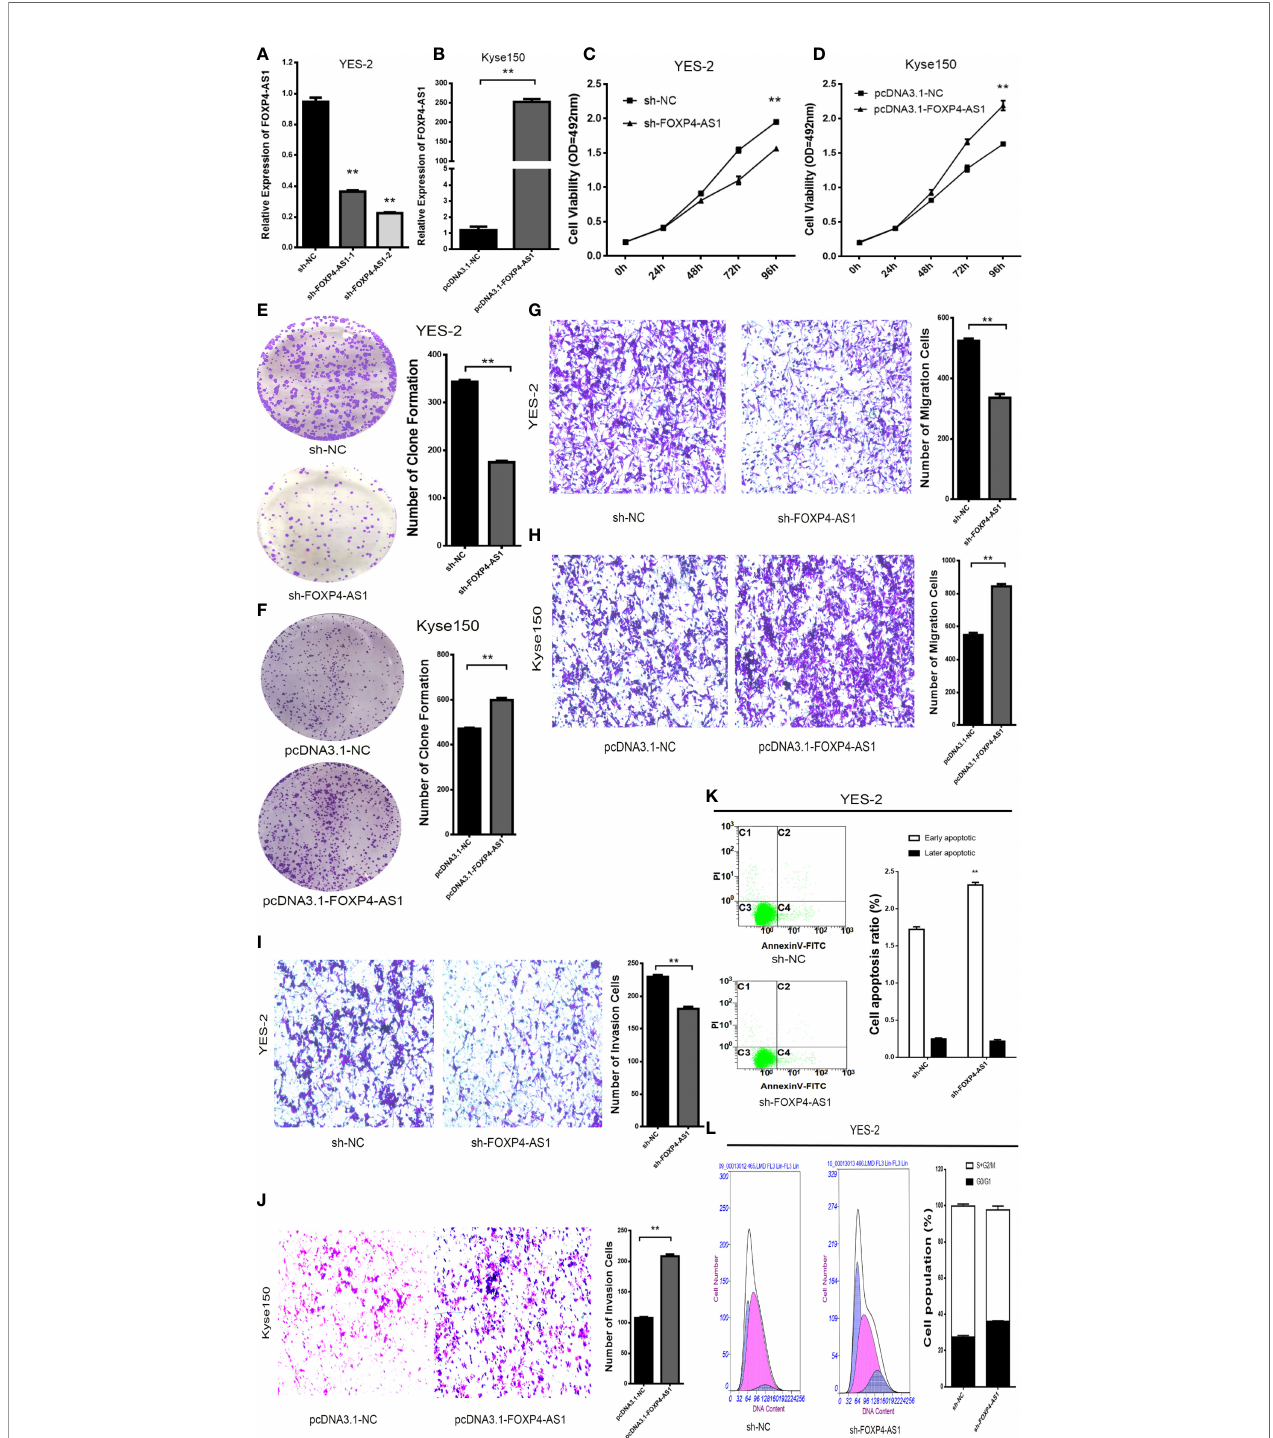
FIGURE 2 | FOXP4-AS1 promotes the malignant progression of ESCC. Expression of FOXP4-AS1 in transfected sh-FOXP4-AS1 (A) or pcDNA3.1-FOXP4-AS1 (B) by qRT – PCR. (C) MTS assay showing the inhibition of YES-2 proliferation ability with sh-FOXP4-AS1. (D) Increased proliferative capacity of Kyse150 with pcDNA3.1-FOXP4-AS1 by MTS assay. (E) Colony formation assay indicates that the number of colony formation in YES-2 cells was reduced after FOXP4-AS1 deregulation. (F) Improved colony formation in Kyse150 cells transfected with pcDNA3.1-FOXP4-AS1. Transwell migration (G) and invasion assays (I) showing the decreased trans-cells of YES-2 with sh-FOXP4-AS1. Transwell migration (H) and invasion assays (J) demonstrated more Kyse150 trans-cells with pcDNA3.1- FOXP4-AS1. Apoptosis (K) and cycle (L) pro fi les of YES-2 cells transfected with sh-FOXP4-AS1 by FCM. ** p <